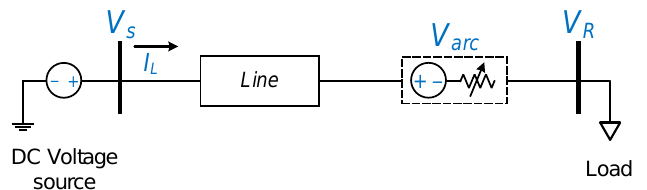
Figure 4. Equivalent circuit diagram of the series arc fault experiment setup.